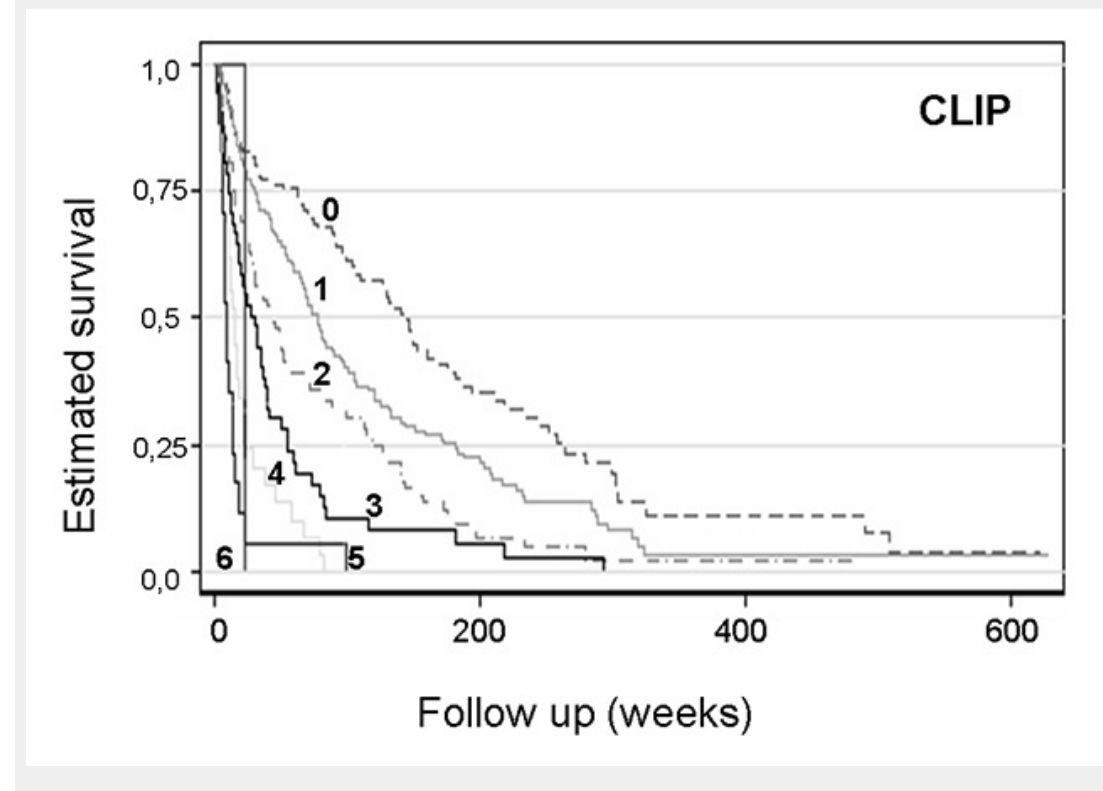
Figure 4 Kaplan-Meier curve for survival by CLIP score in patients with hepatocellular cancer (n = 131, 155, 95, 51, 23, 17 and 3 for CLIP 1‒6, respectively). CLIP = cancer of the liver Italian